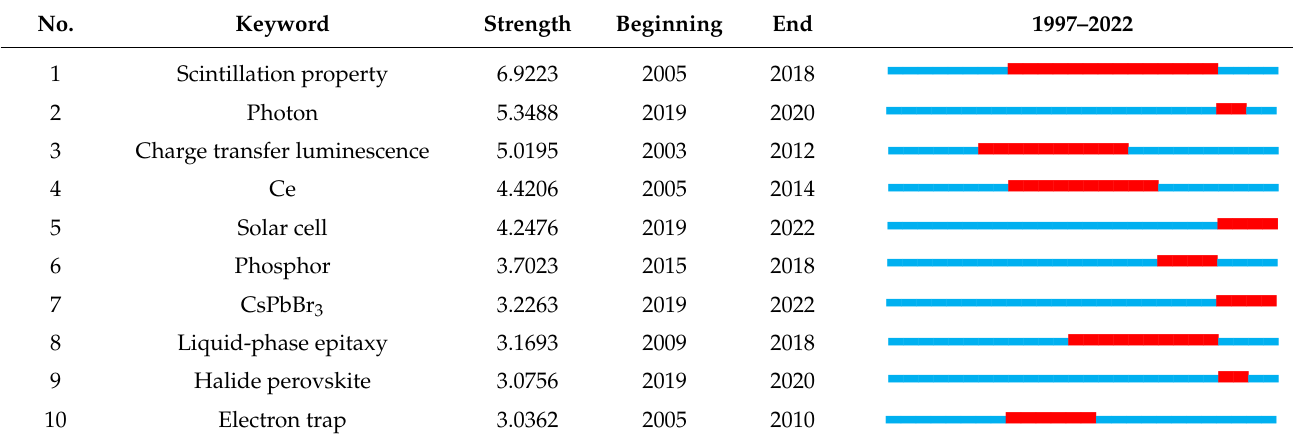
X-ray detectors.